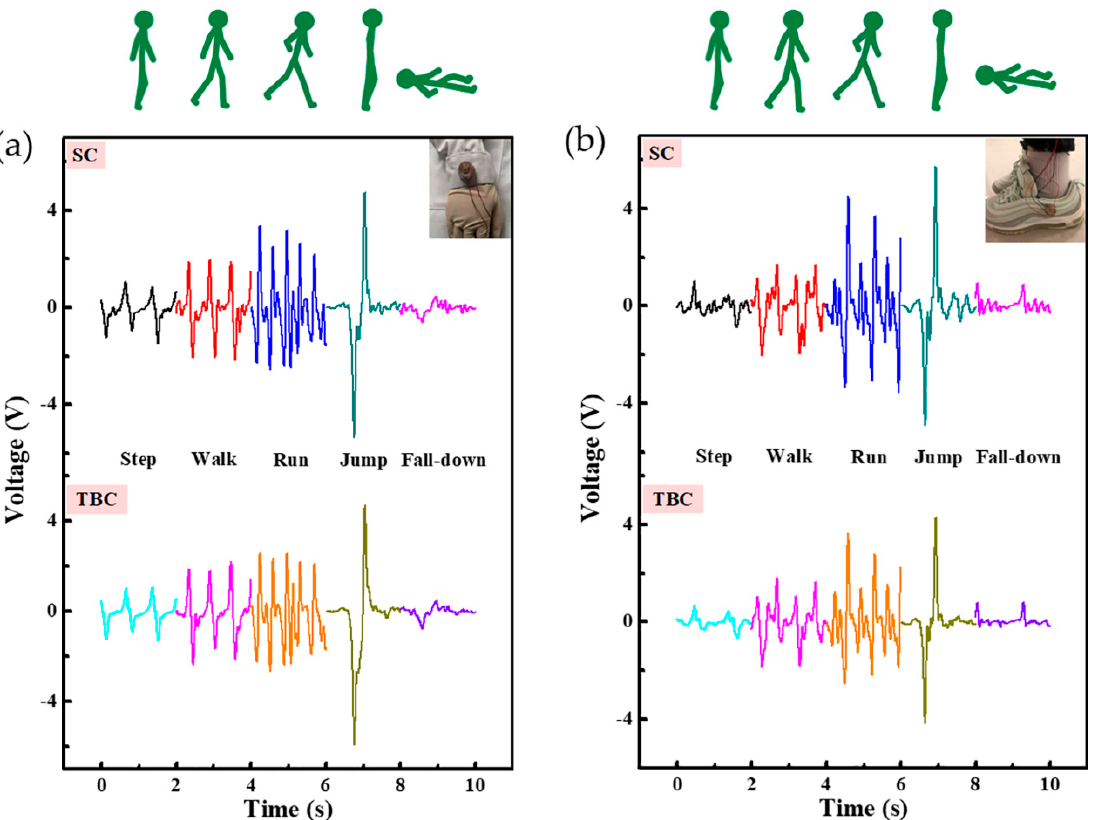
Figure 3. Motion state monitoring signals (Step, Walk, Run, Jump, Fall-down) of the SWS in different wearing parts — ( a ) wrist and ( b ) shoe.